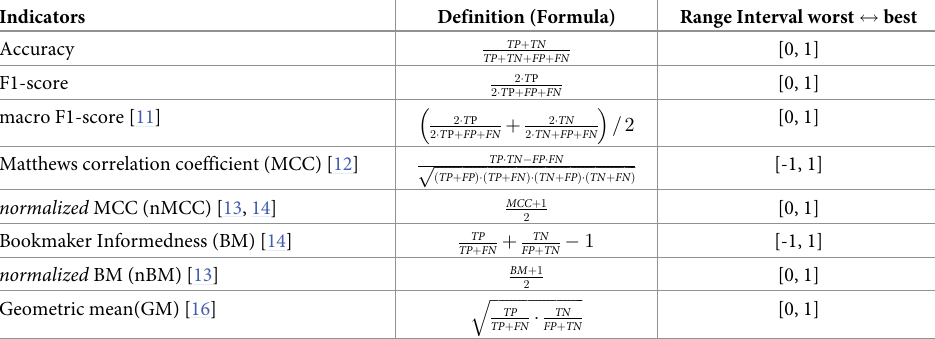
Table 1. Evaluation indicators to evaluate and compare the performance of Computer-Aided Nodule Assessment and Risk Yield. Indicators